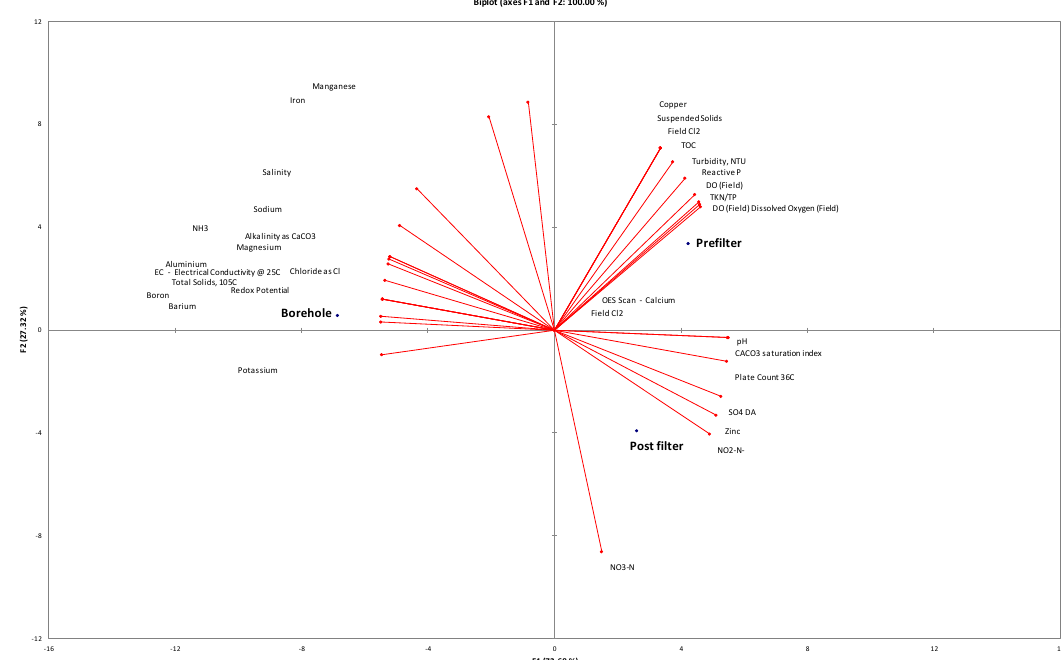
Figure 2. Principal component analysis of three types of water: Borehole, Pre- and Post-filter. Measurements for carbonate and hydroxide alkalinity as CaCO 3 , Arsenic, Beryllium, Cadmium, Chromium, Cobalt, Lead, Mercury, Nickel and Vanadium were below the detection limit for the three types of water.